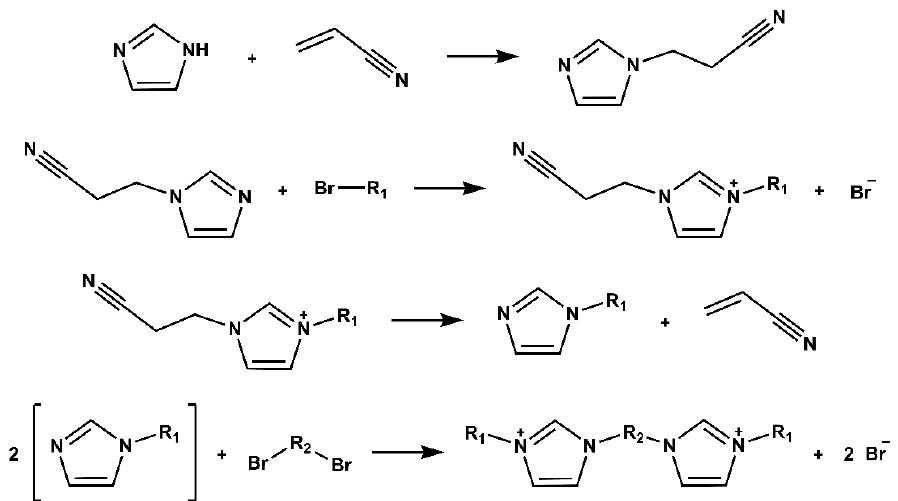
Scheme 1. Schematic representation of the synthesis of ionic liquids and ionic liquid-based surfac- tants. MW and US refer to microwave and ultrasound irradiation, respectively.